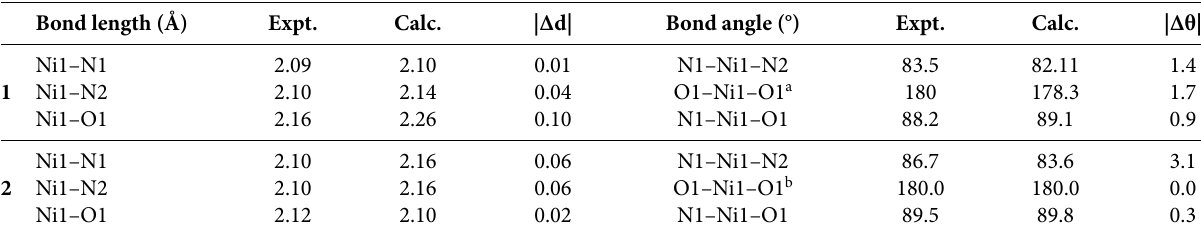
Table 4. Selected geometric parameters from X-ray experiment and DFT-B3LYP calculations Bond length (Å) Expt. Calc. |Δd| Bond angle (°) Expt. Calc.